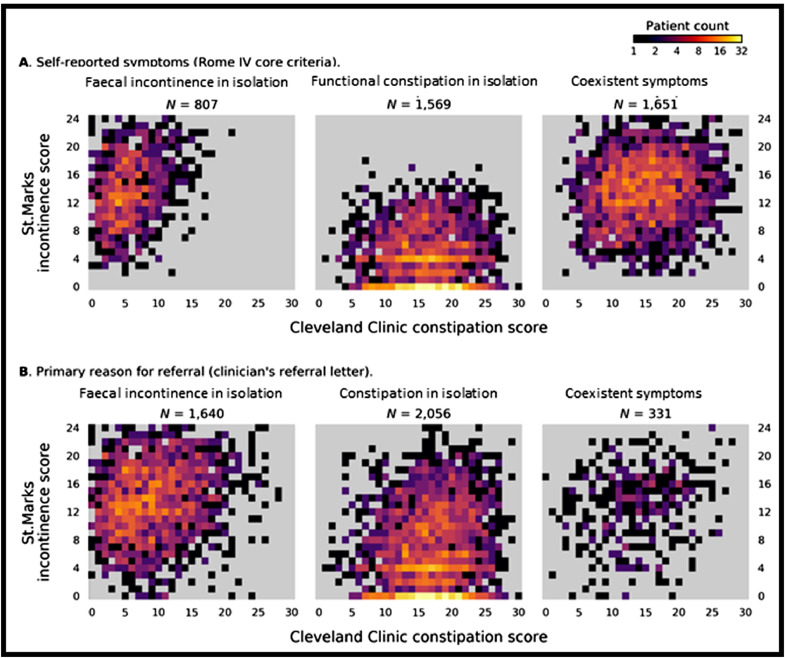
Colour density plots showing symptom severity of faecal incontinence (St Marks incontinence score: Y-axis) and constipation (Cleveland Clinic constipation score: X-axis) in 4027 patients, classified by: A. Self-reported symptoms: Rome IV core criteria. B. Primary reason for referral stated in the clinicians’ referral letter. The right panels in A and B show that coexistent faecal incontinence and constipation are frequently missed by the referring clinician; B shows that patients with all degrees of symptom severity are missed (i.e. not just those with less severe symptoms).